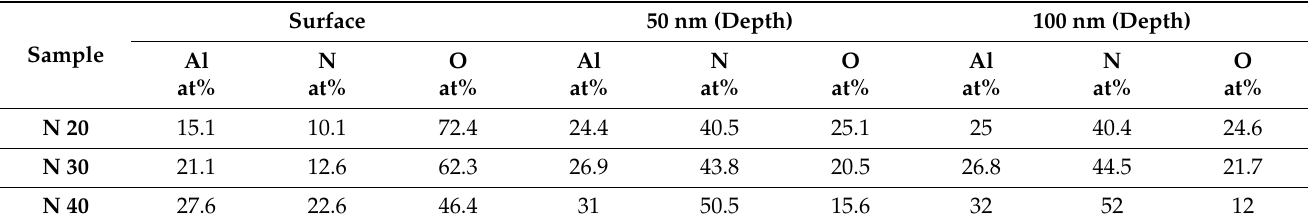
Table 1. Various atomic percentages (at%) of elements identified in AlN thin films at the surface and at depths of 50 and 100 nm.